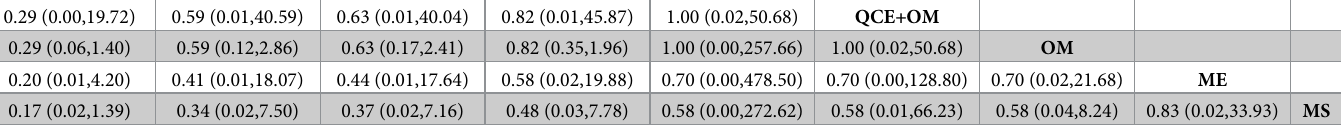
Mayo scores. The improvement of Mayo scores was reported in 11 RCTs and involved 5 therapies. Compared with OM (Table 2), OQC+QCE (SMD = 3.21, 95%CI:1.77, 5.81) and